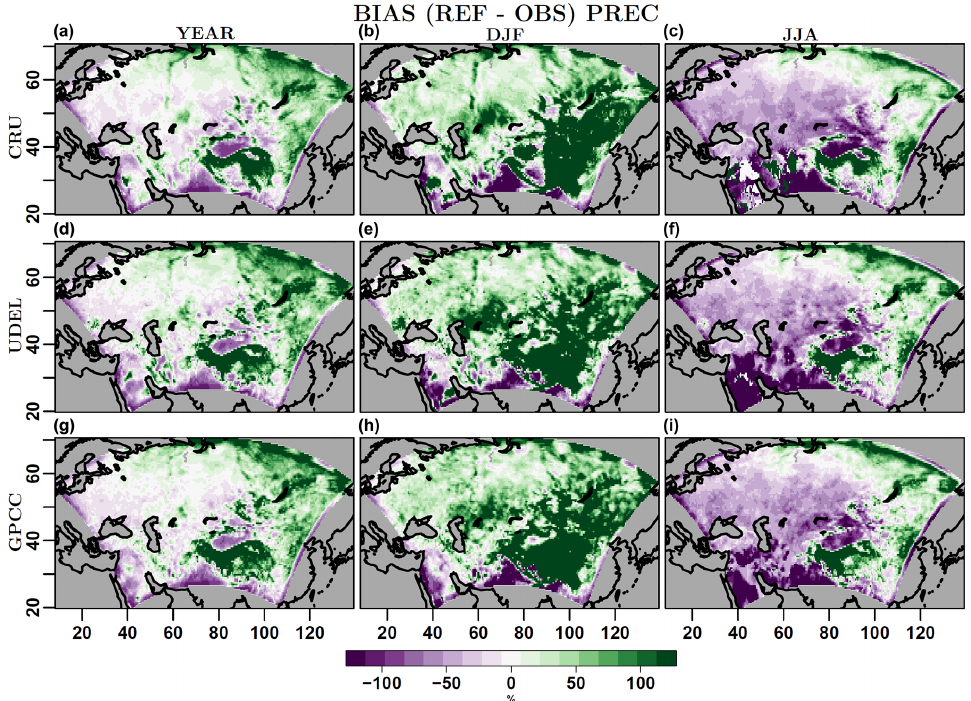
Figure 5. Mean bias of annual (a, d, g) , winter (b, e, h) and summer mean (c, f, i) relative precipitation (PRE, %), of the reference COSMO- CLM simulation a with respect to three observational data sets (from top to bottom: CRU, UDEL and GPCC), for the period 1995–2005.